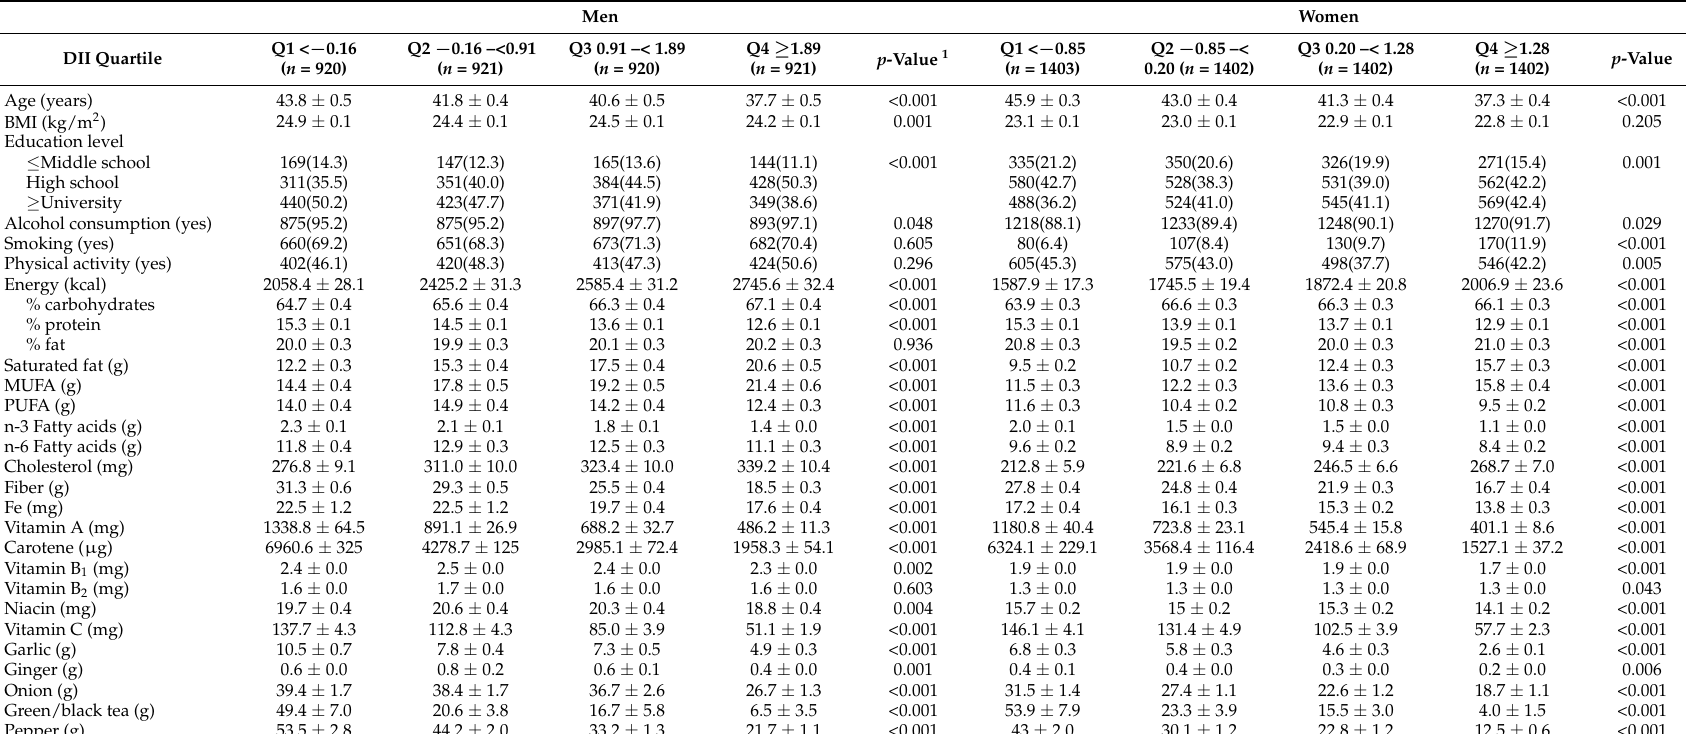
Table 2. Characteristics and nutrient and food intake of the subjects according to DII